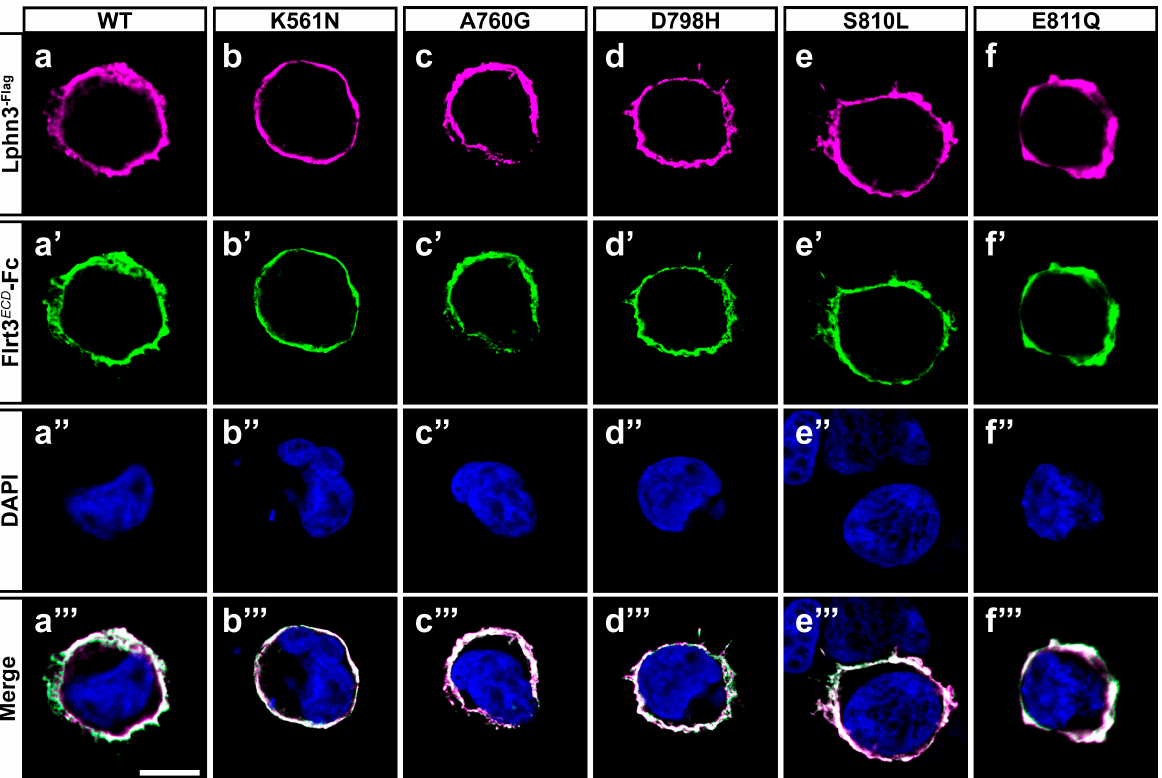
Figure 2. Cancer-related GAIN domain mutations do not abrogate Lphn3 interaction with Flrt3. Representative images of cell surface labeling assays conducted by incubating HEK293 cells expressing Lphn3 or its variants with a soluble recombinant protein corresponding to the extracellular region of Flrt3 fused to IgG constant fraction (Flrt3 ECD -Fc). Cells were visualized by confocal microscopy using ( a – f ) anti-Flag antibody (red fluorescent signal from secondary antibody coupled to Alexa 633) recognizing Lphn3 N-terminal, ( a’ – f’ ) anti-human IgG antibody (green fluorescent signal from secondary antibody coupled to Alexa 488) recognizing surface-bound Flrt3 ECD -Fc, ( a” – f” ) DAPI for nuclei staining. ( a”’ – f”’ ) Merged images from corresponding series. Scale bar: 10 µ